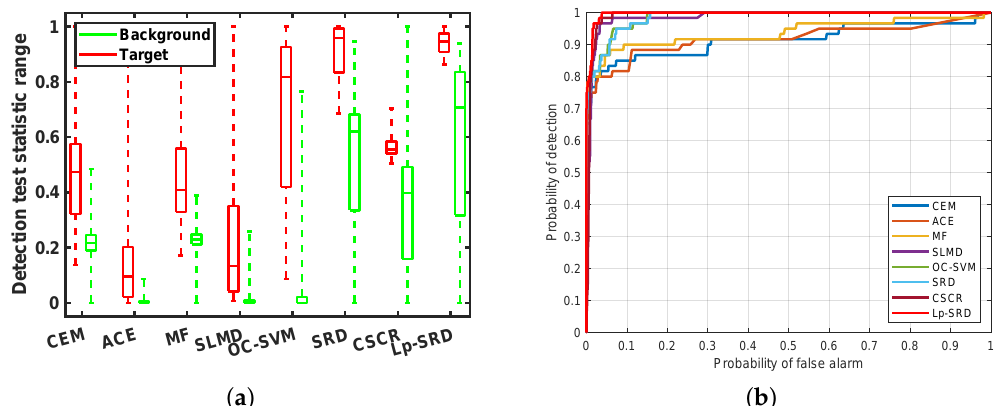
Figure 16. Detection performance using the Gulfport dataset: ( a ) Statistical separability analysis. ( b ) Receiver operate characteristic (ROC) curves.